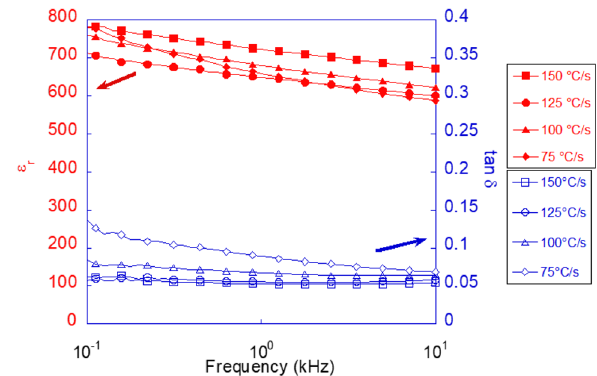
Fig. 3 Dielectric constant (ε ) and dielectric loss (tan δ ) vs. fre- r quency for 210 nm films annealed for 1 min, 5 min, and 10 min at 700 °C with a ramp rate of 100 °C per second